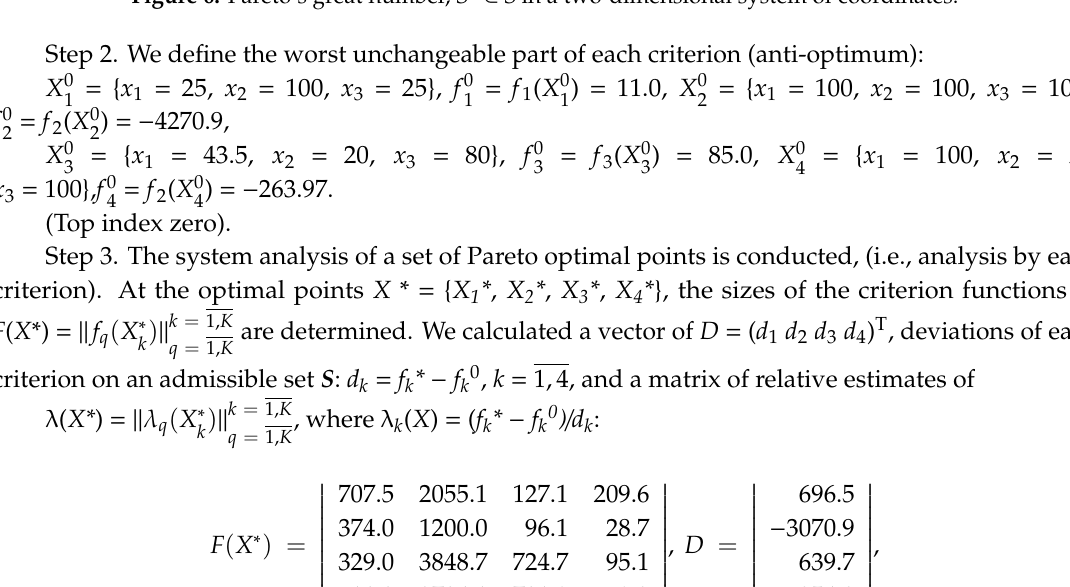
Figure 6. Pareto’s great number, S 0 ⊂ S in a two-dimensional system of Figure 6. Pareto ’ s great number, S 0  S in a two-dimensional system of coordinates.